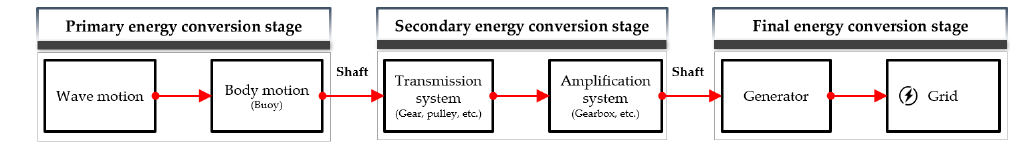
Figure 2. Step-by-step process of energy conversion through movable object type wave power gen- erator.